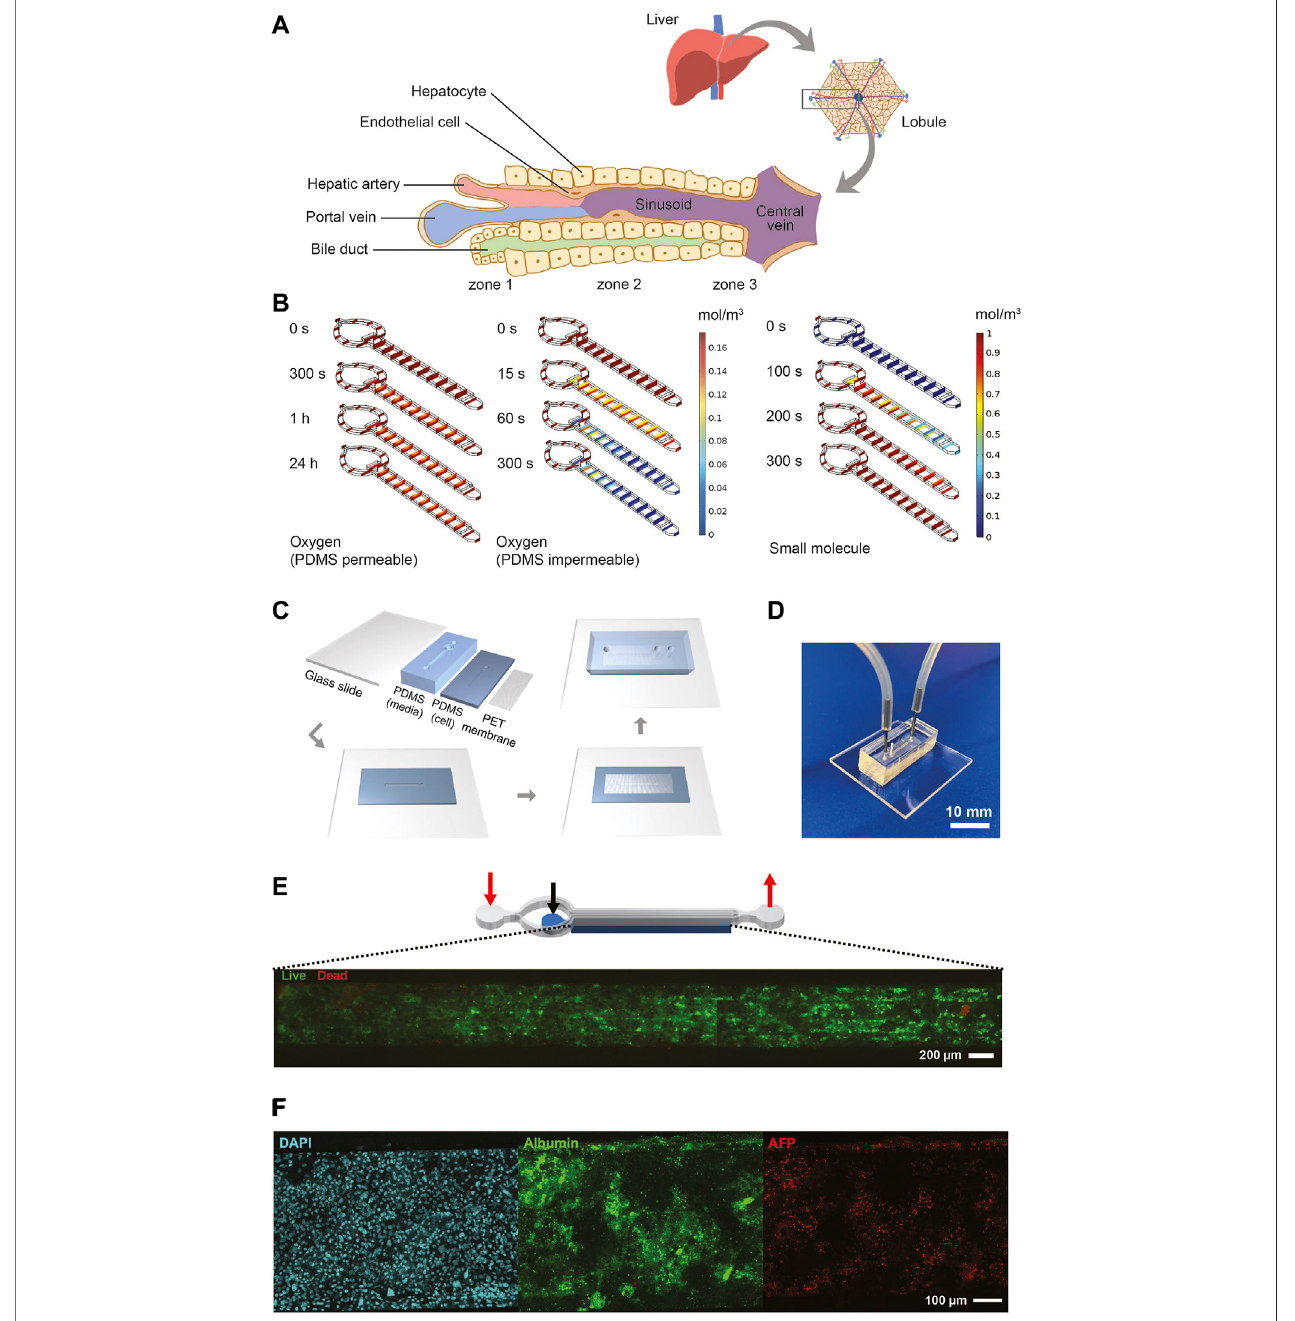
FIGURE2| Design,characterization,fabrication, andtestingofliverMPS. (A) Illustrationshowingtheliveracinusasthebasicbuildingblockoftheliverinspiringthe liverMPSdesign. (B) COMSOL ® simulationresults.Smallconcentrationgradientswithphysiologicallyrelevantoxygenlevelsareobservedwhencellsinthecellchamber consume oxygen and oxygen diffuses from the ambient through the PDMS roof and walls (left) . When oxygen is not diffused through the PDMS cells become hypoxic after 300 s (center) . The hiPSC-Heps OCR used in the simulations was determined from Seahorse measurements. The oxygen concentration jumps between media channel and cell chamber are due to diffusion across the porous membrane. A dilute solution containing a small molecule entering the media channel at 20 μ L/h diffuses across the porous membrane into the cell chamber and reaches a uniform concentration within the liver MPS within 300 s (right) . Simulation assumes impermeable walls and no cell consumption. (C) Preparation and microfabrication steps of the liver MPS. (D) Photograph of a ready-to-use liver MPS. The catheter couplers link the tubes and micro fl uidic channels for perfusion. The short plug in the middle keeps the loaded cells in the chamber. (E) Schematic of the liver MPS that shows the localization of the cell chamber; the red arrows indicate the inlet and the outlet of the media channels, whereas the black arrow marks the inlet of the cell chamber. High cell viability in the tissue chamber after loading is demonstrated by fl uorescence imaging of acetoxymethyl calcein (calcein-AM; live cells labeled green) and ethidium homodimer (dead cells labeled red). (F) Immuno fl uorescent images of hiPSC-Heps seven days after loading into the liver MPS.